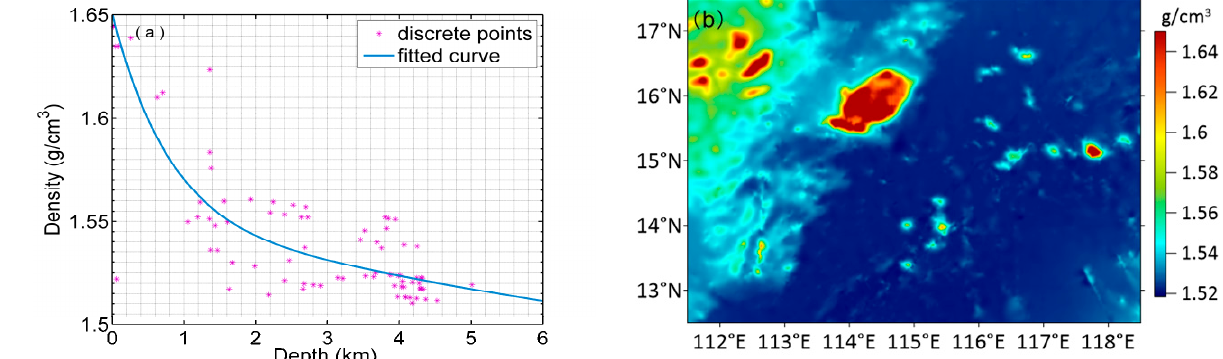
Figure 3. The fitted results of the density contrast: ( a ) fitted curve of the density contrast with depth and ( b ) fitted density contrast model.